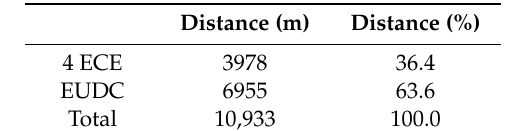
Figure 16. Comparison between test and NECD energy consumption.